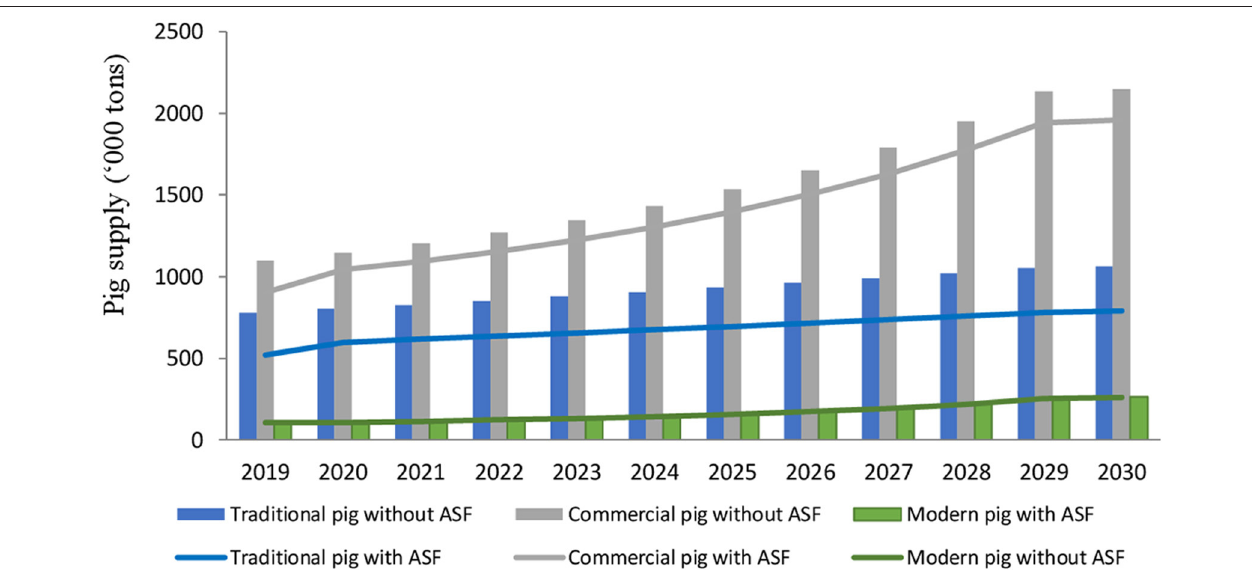
FIGURE 2 | Pig supply projection with and without ASF outbreak under baseline assumptions (20% reduction in demand from traditional and commercial sectors) (Source: Model simulations). The bars are the baseline, and the lines are the level